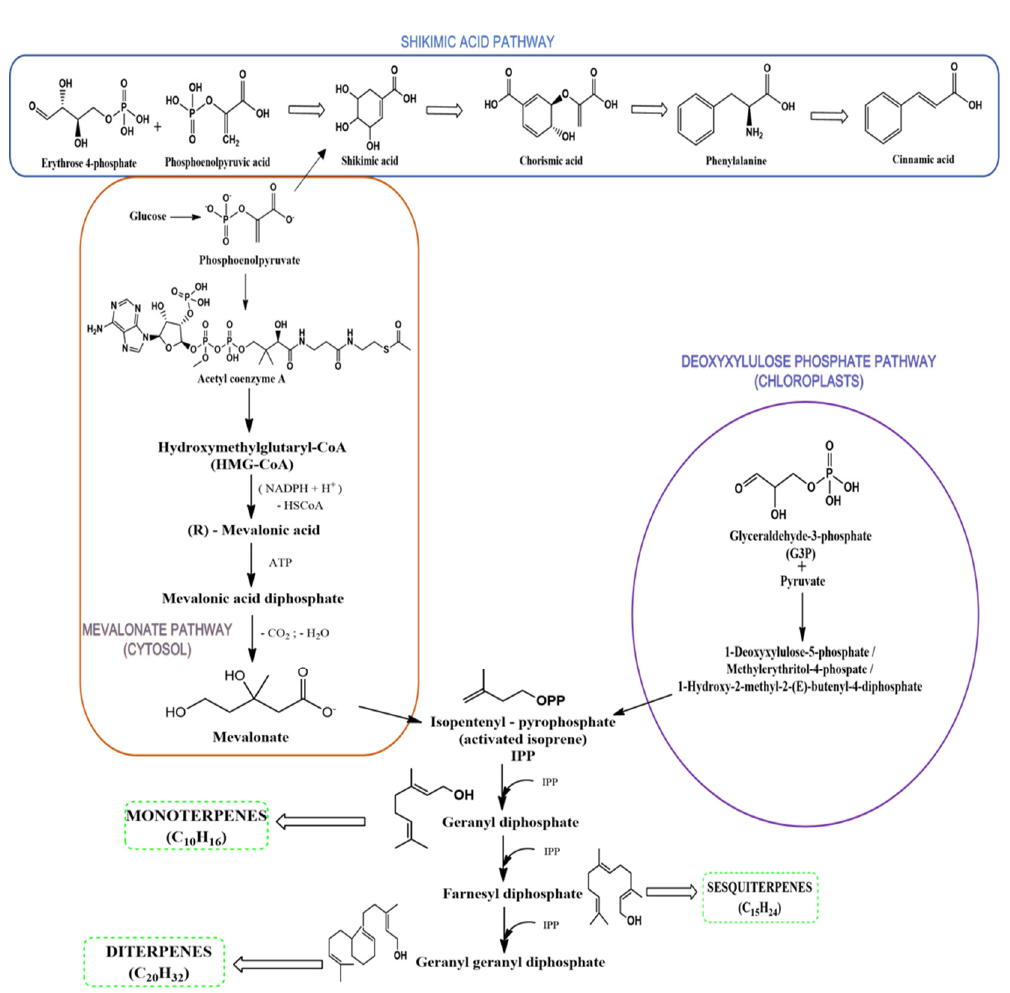
Figure 1. Biosynthesis pathways of terpenoids, according to the literature